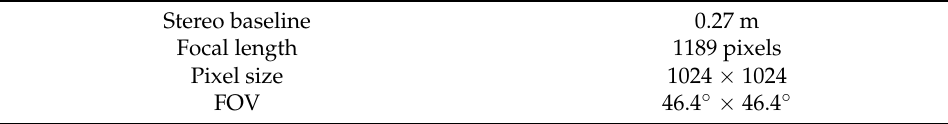
Table 3. Geometric parameters of Chang’e-4 Navcam stereo cameras.